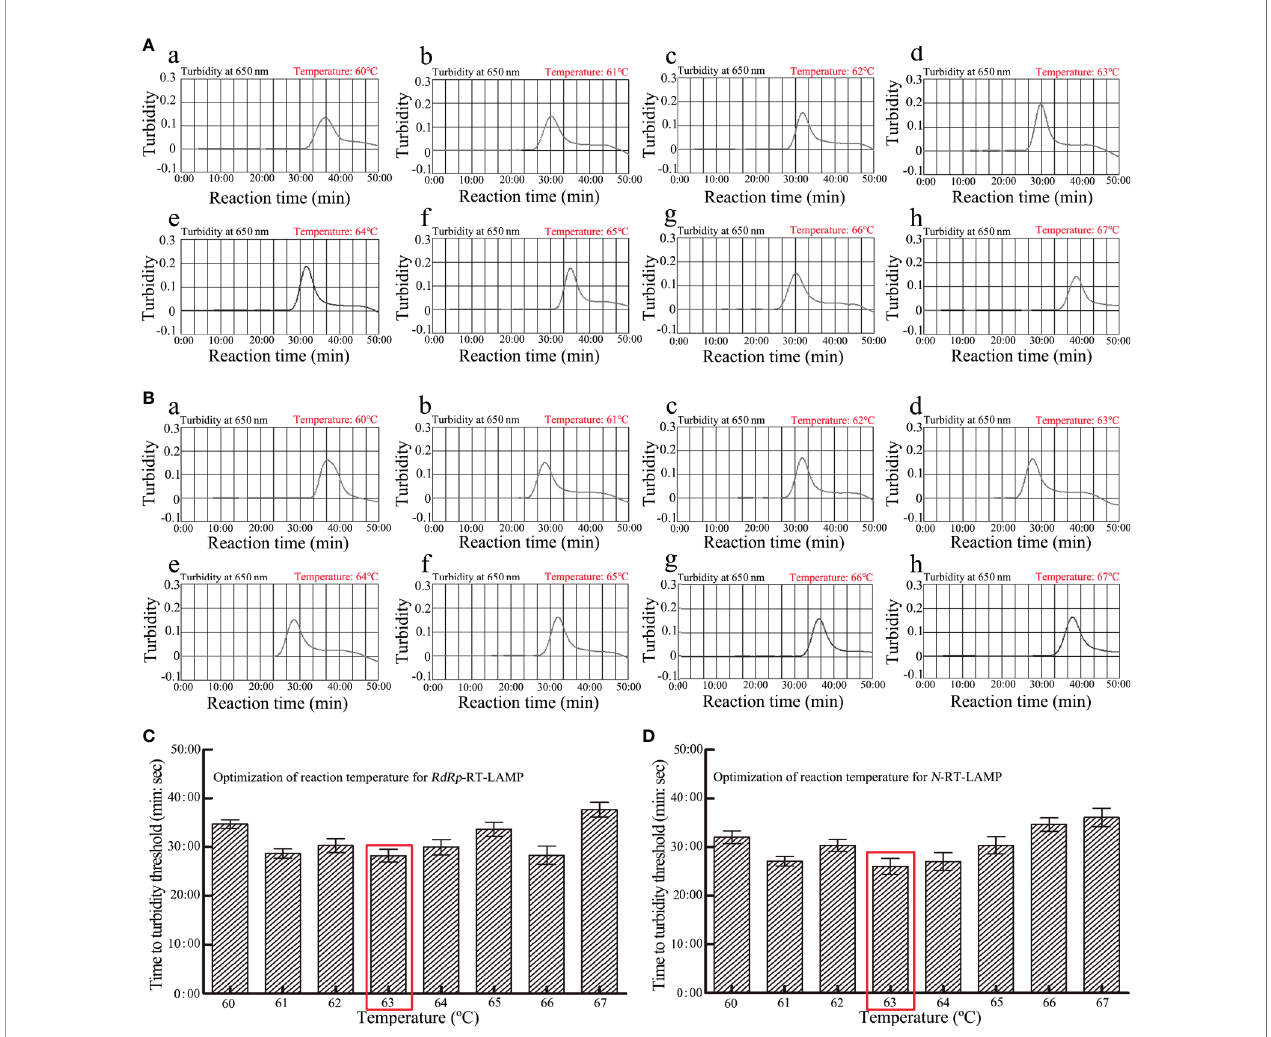
FIGURE 3 | Optimization of ampli fi cation temperature for RdRp -LAMP (A) and N -LAMP (B) primer sets. The LAMP ampli fi cations for detection of RdRp (A) and N (B) were monitored through real-time turbidity and the corresponding curves of amplicons were displayed in the graphs. The threshold value was 0.1 and the turbidity>0.1 was considered as positive. 8 kinetic graphs were obtained at different temperatures (60-67°C, 1°C intervals) with 1×10 4 copies target genomic RNA per reaction. (C) Optimization of reaction temperature for RdRp -RT-LAMP; (D) Optimization of reaction temperature for